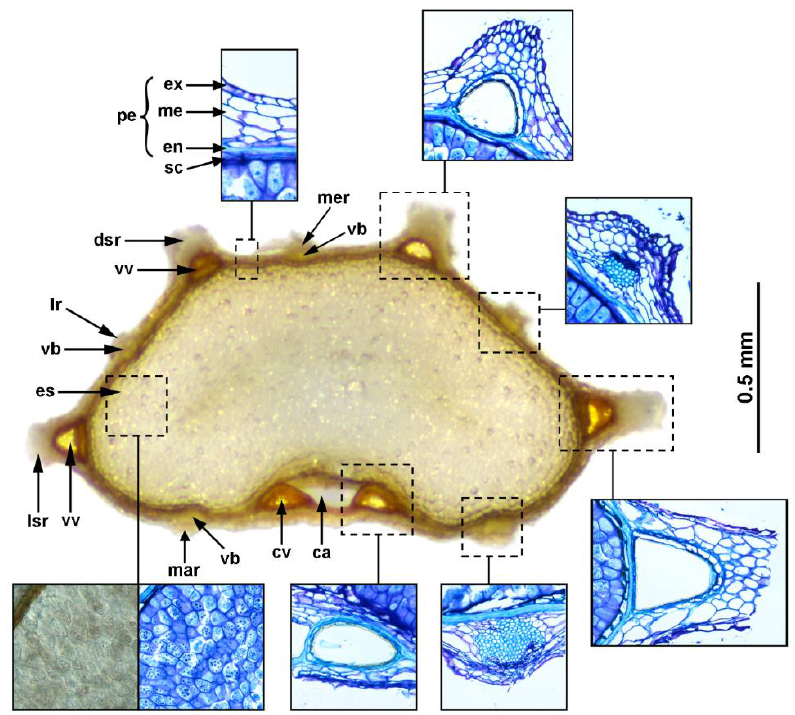
Figure 1. Transverse section of a mericarp of Daucus sp., indicating the anatomical structures considered in this study and their terminology. The insets show the corresponding structures, as seen by light microscopy. Abbreviations: ca, cavity; cv, commissural vitta; dsr, dorsal secondary rib; en, endocarp; es, endosperm; ex, exocarp; lr, lateral primary rib; lsr, lateral secondary rib; mar, marginal primary rib; me, mesocarp; mer, median primary rib; pe, pericarp; sc, seed coat; vb, vascular bundle; vv, vallecular